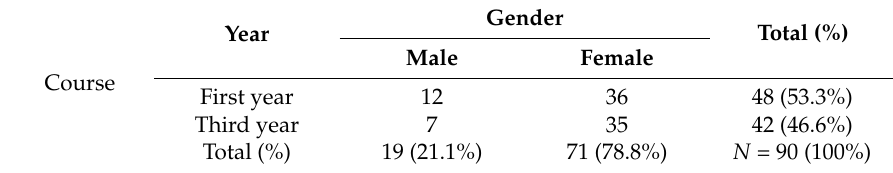
Table 1. Student